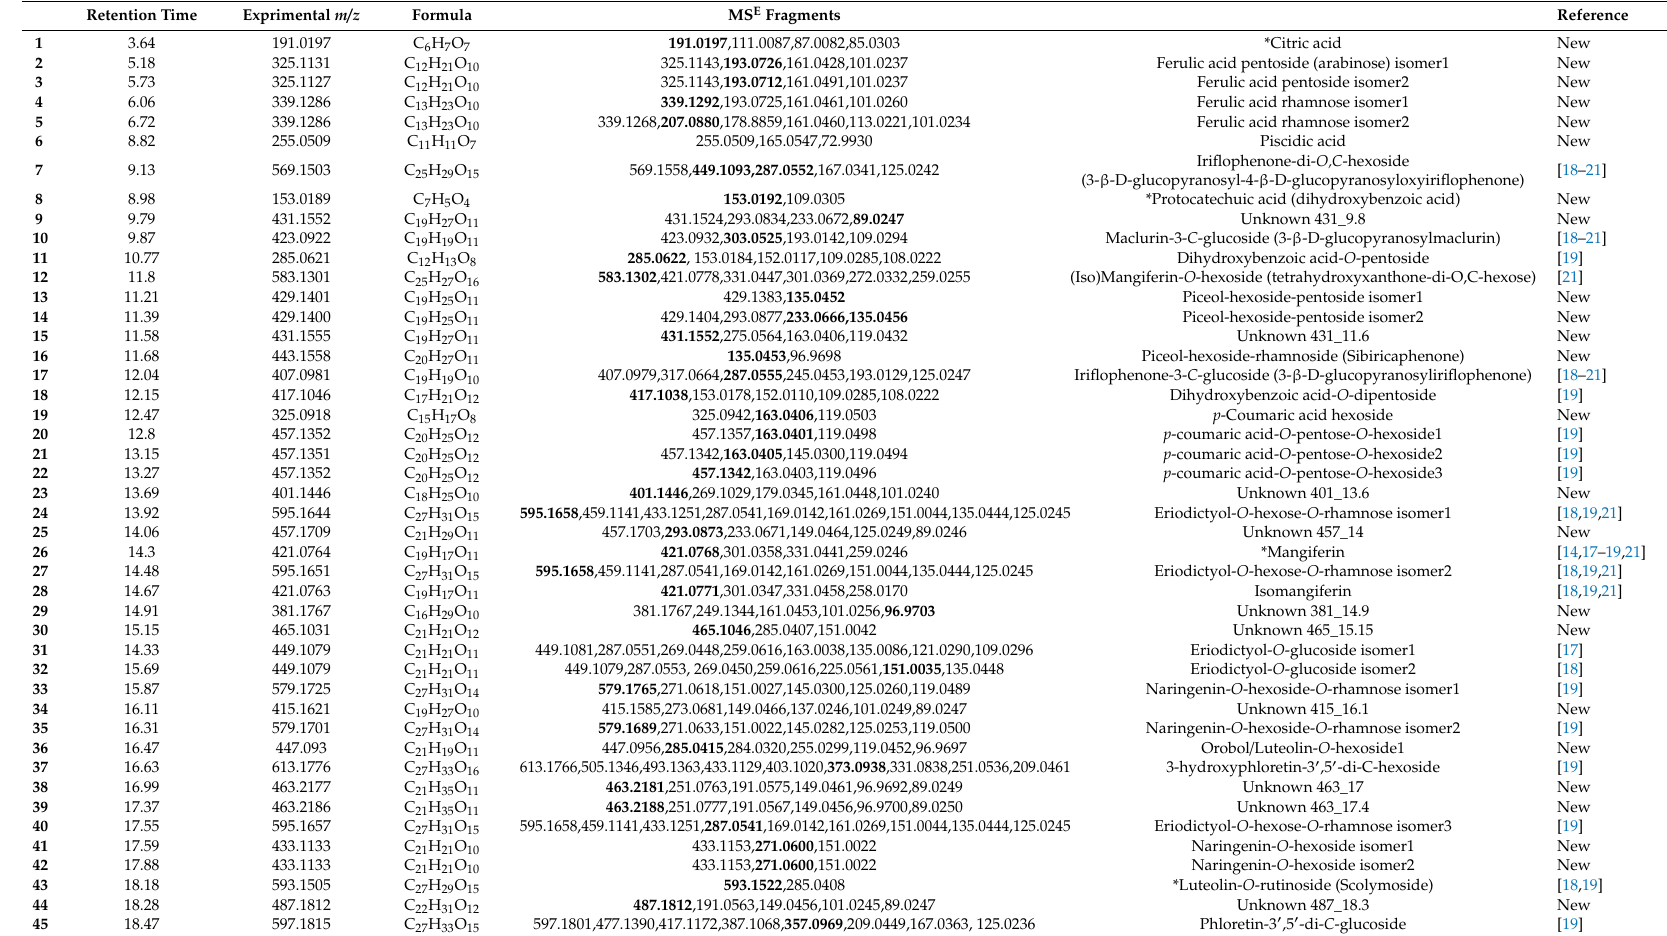
Table 1. List of compounds tentatively identified in Cyclopia extracts in this study showing compound number, retention time, detected [M-H] ion, elemental composition and MS E fragments as well as literature references to where the compounds were previously